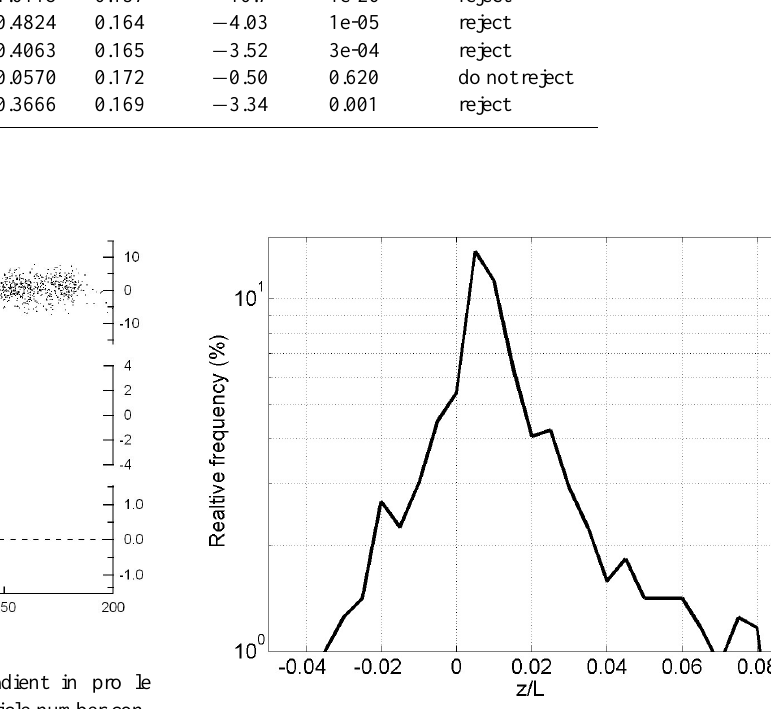
Fig. 6. Probability density function of the stability parameter z/L , based on the whole ASCOS measurement period near the